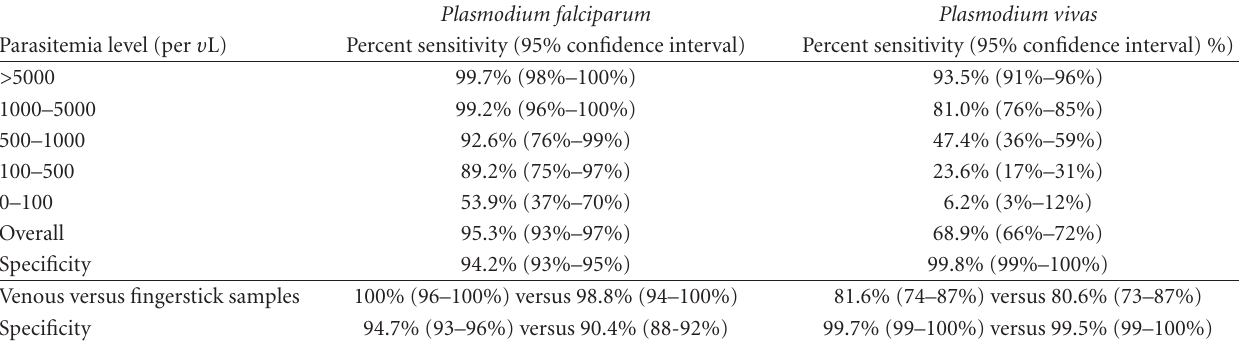
Table 2: Performance characteristics of the BinaxNOW (cid:2) malaria kit for Plasmodium falciparum and P. vivax (data obtained from package insert)